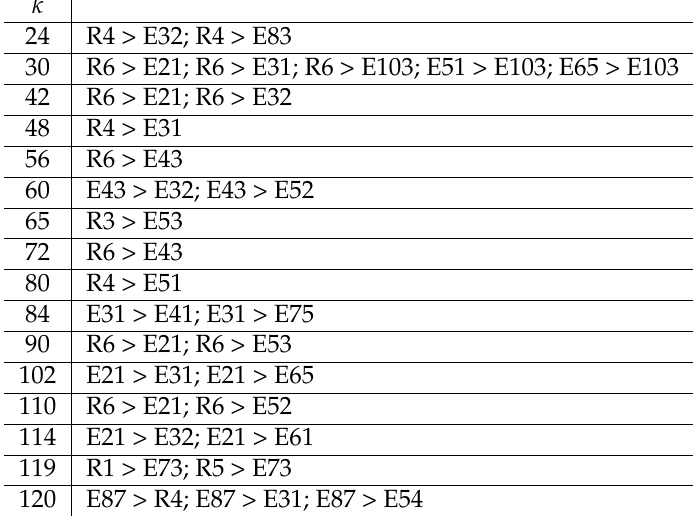
Table 6. Rules and Expressions superseding other Rules and